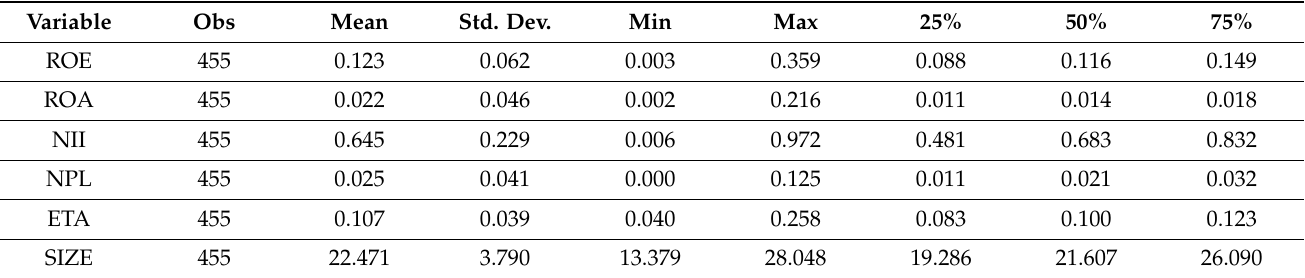
Table 2. Summary